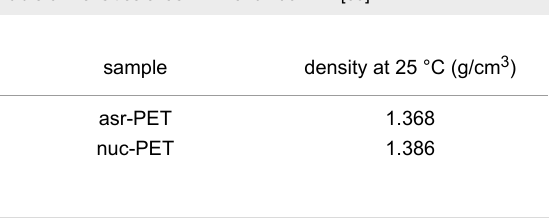
Table 3: Densities of asr-PET and nuc-PET